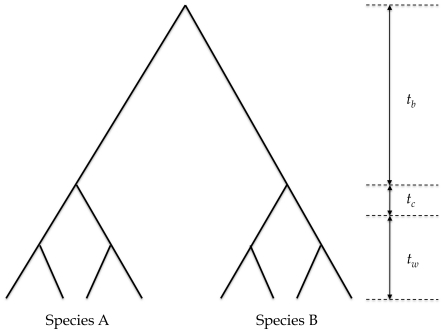
Tree illustrating the time between the most recent common ancestors of each species (tb), the expected time to coalescence for two randomly chosen lineages within a given species (tw) and the difference between tw and the time at which all lineages coalesce (tc).